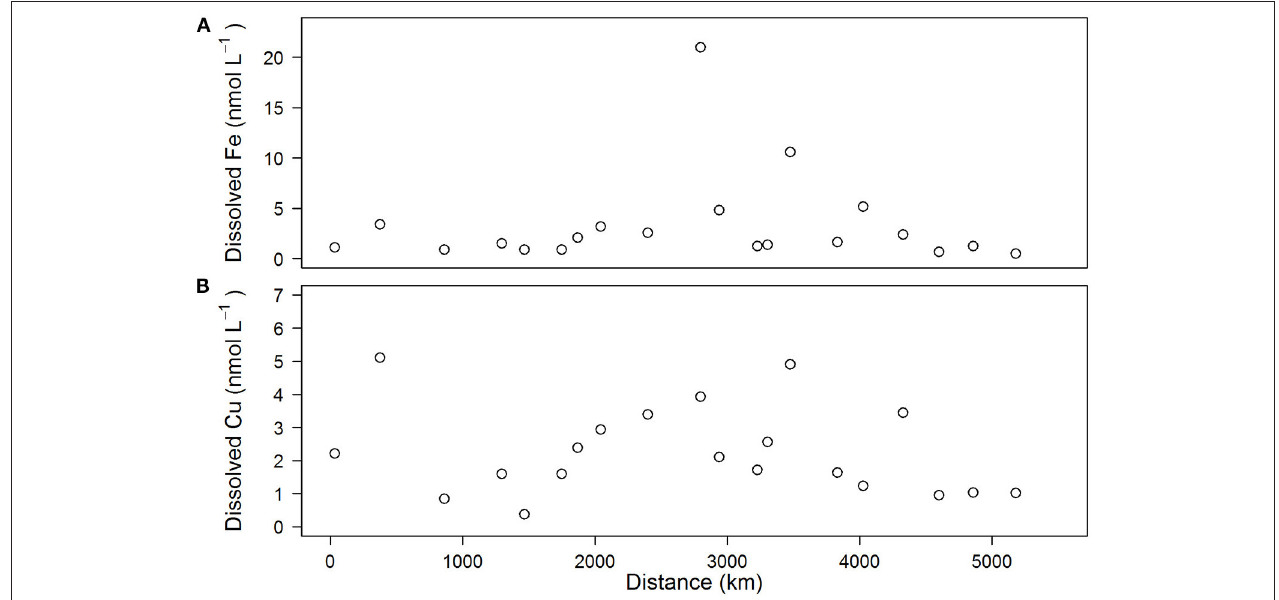
FIGURE 3 | Concentrations of dissolved iron (A) and dissolved copper (B) observed in underway samples plotted as a function of distance along the cruise track.